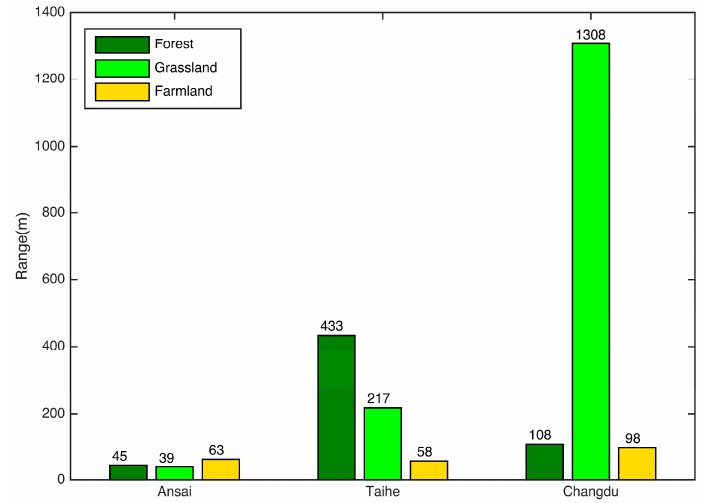
Figure 12. Appropriate scales for forest, grassland, and farmland at the study sites.